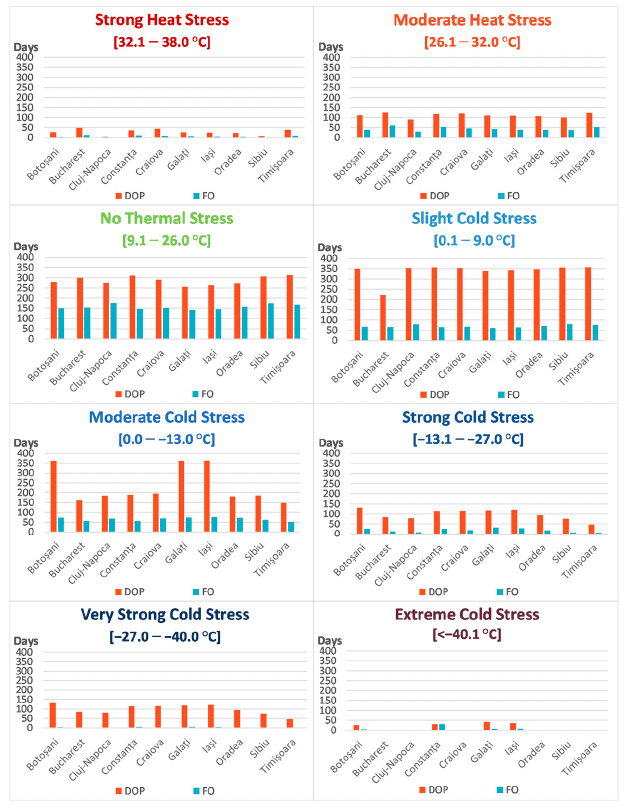
Figure 11. DOP and FO for the UTCI index by thermal sensations classes and weather stations (number of days).